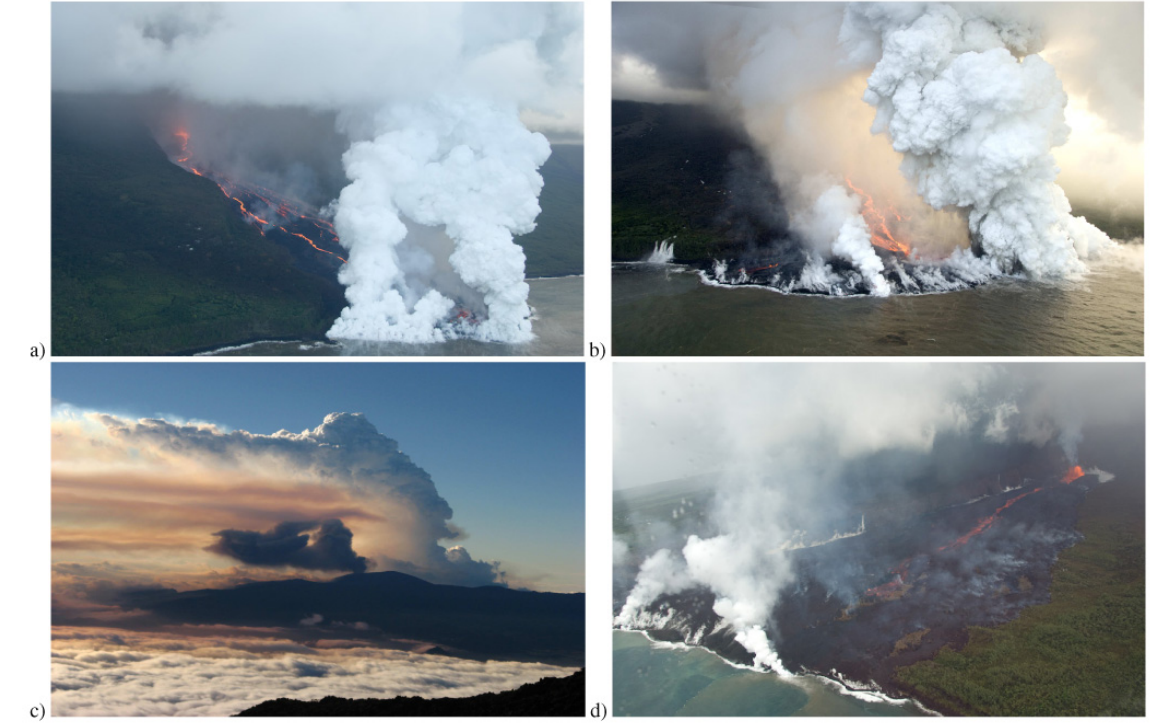
Fig. 1. ( a , b and d ): lava flow on Le Grand Brˆul´e area near the Piton Tremblet crater on 5, 6 and 8 April 2007, respectively. Copyright F. Caill´e. (c) : three different plumes over the Piton de la Fournaise during the collapse of the Dolomieu crater on 6 April 2007. Copyright R.